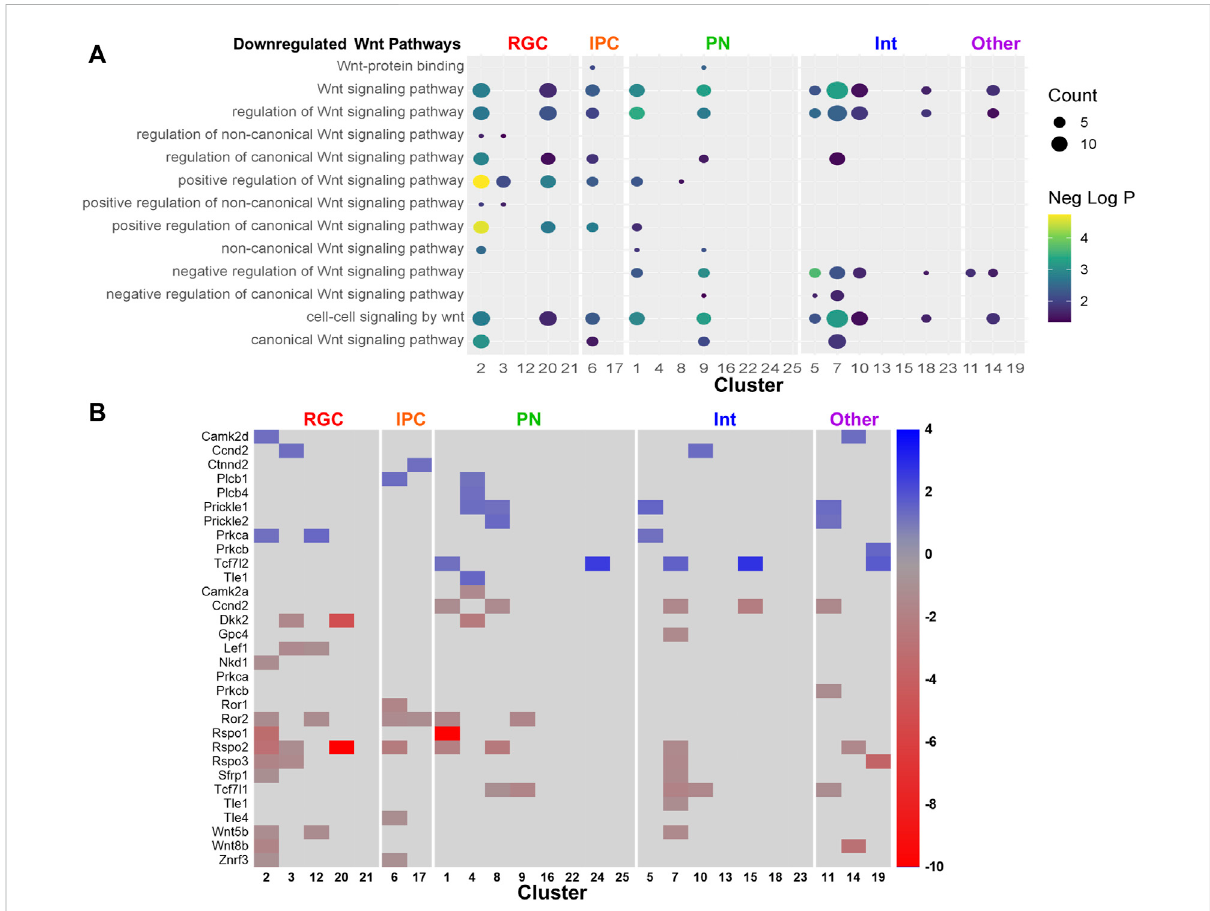
FIGURE 7 Wnt signaling pathways and genes altered by PAE. (A) Dot plot downregulated Wnt-related pathways. (B) Heatmap of the fold-change of Wnt signaling related